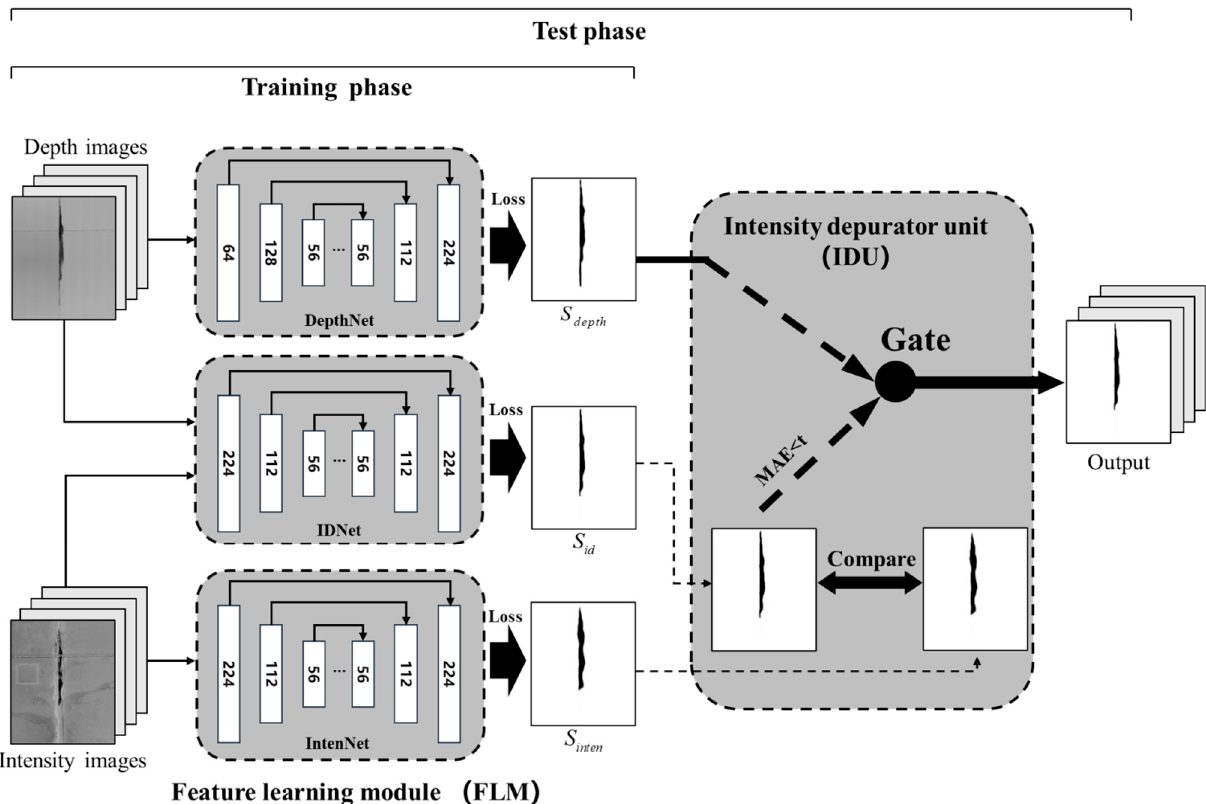
Figure 7. Framework illustration of the SIDNet model with the training phase and the test phase.